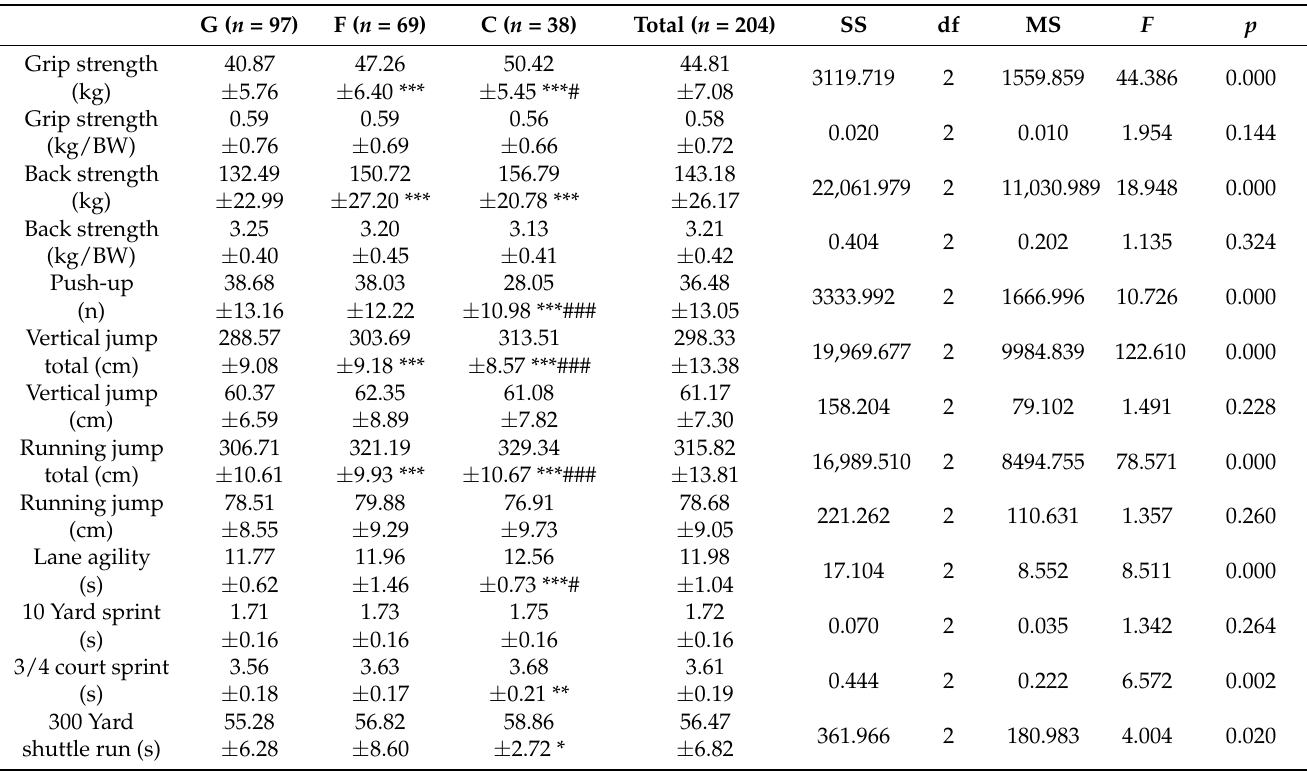
Table 3. Differences in physical strength according to the play